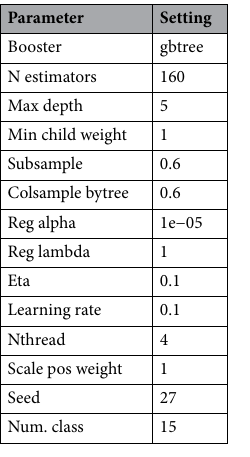
Table 3. The optimal parameters of XGBoost.